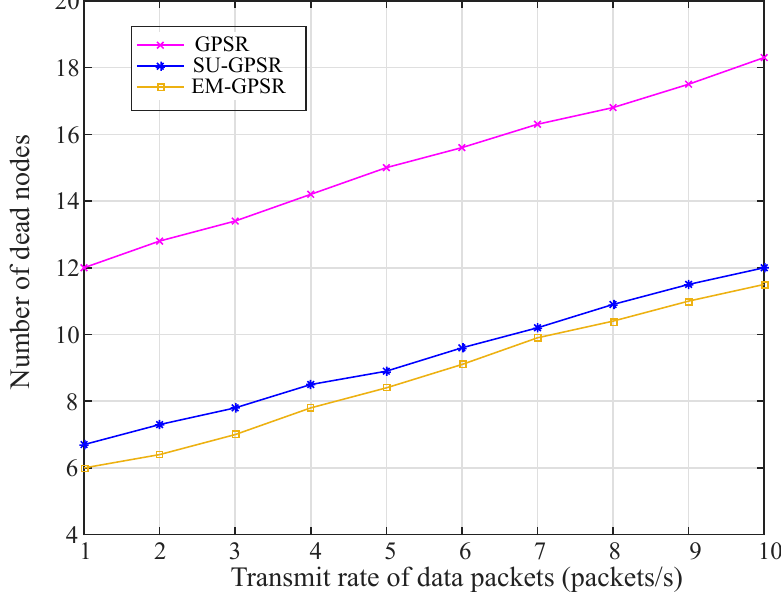
Figure 15. The number of dead nodes versus the transmit rate of data